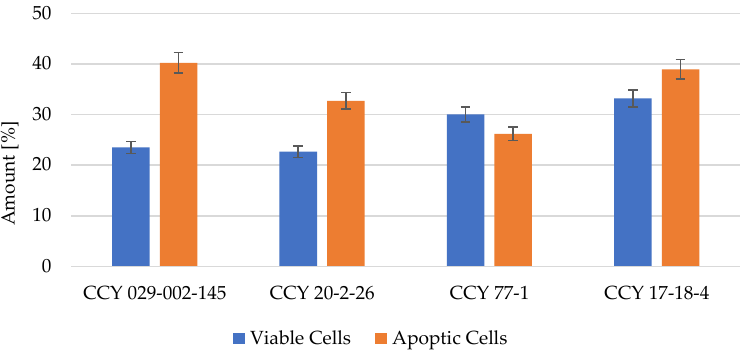
Figure 9. Ratio of viable and apoptotic cells after microbial extract treatment.